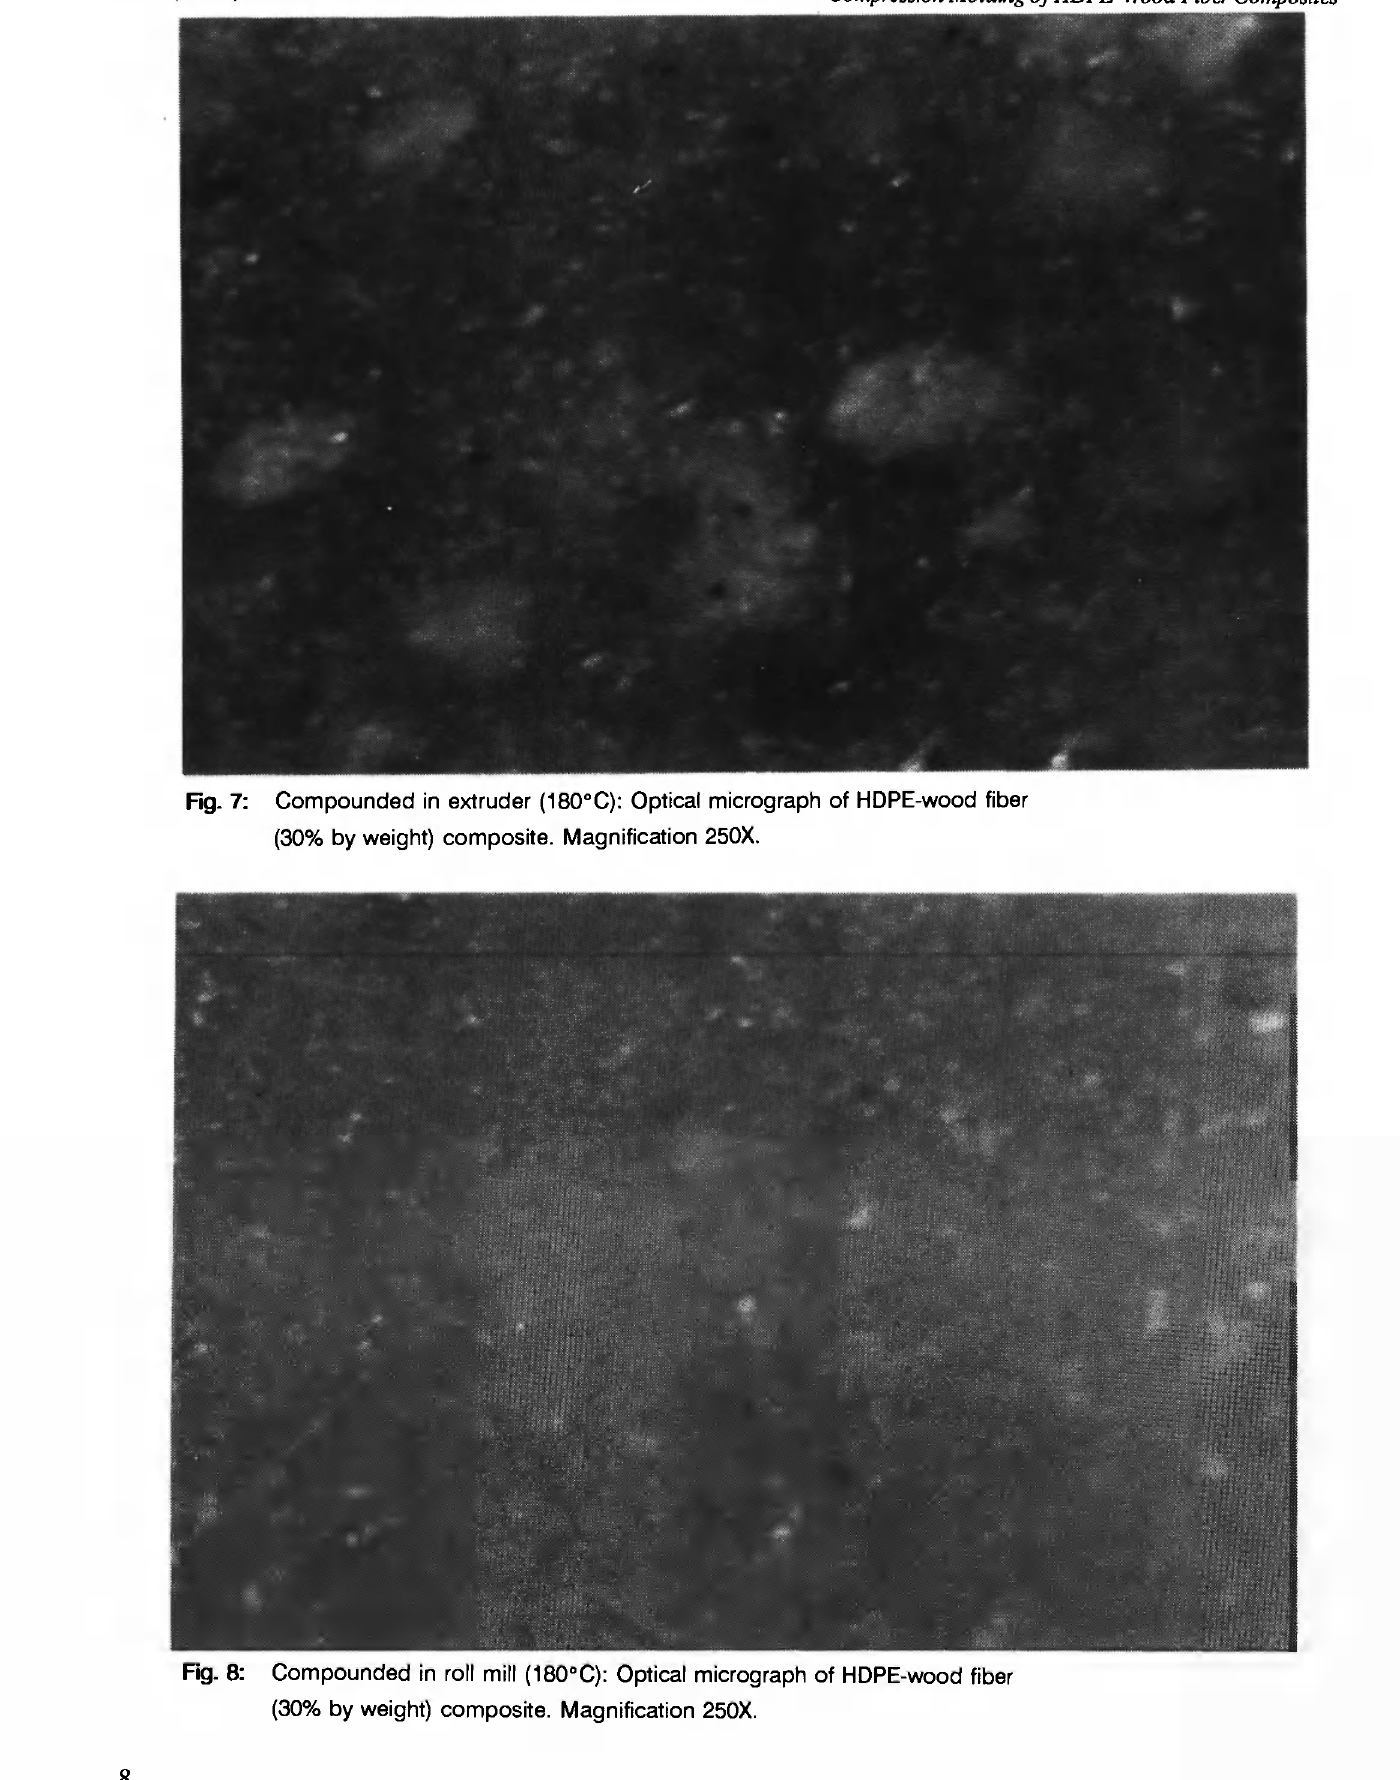
Fig. 8: Compounded in roll mill (180°C): Optical micrograph of HDPE-wood fiber (30% by weight) composite. Magnification